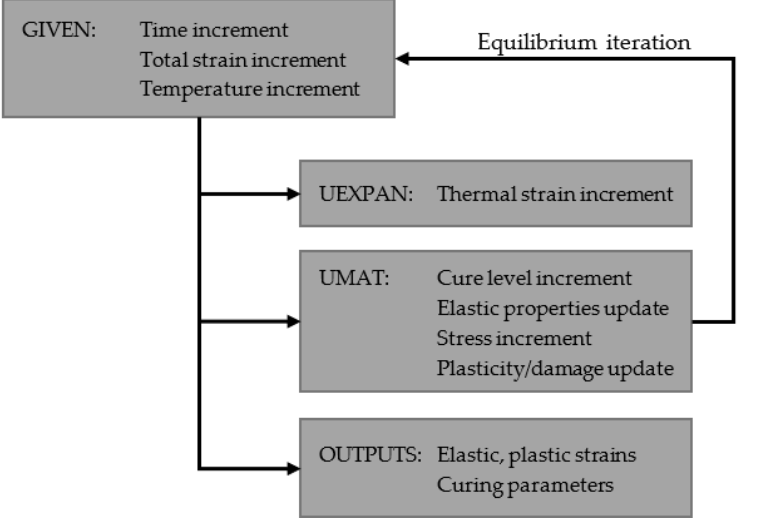
Figure 2. Model solution procedure.